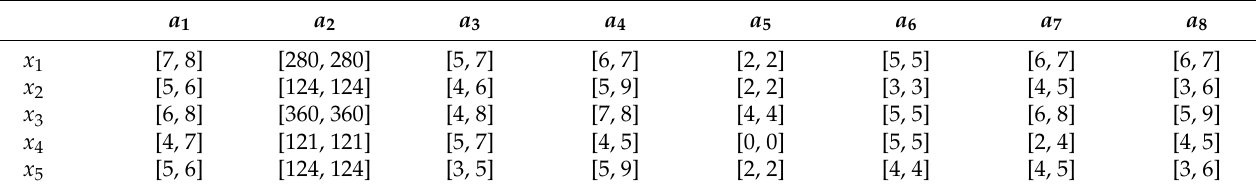
Table 1. Decision